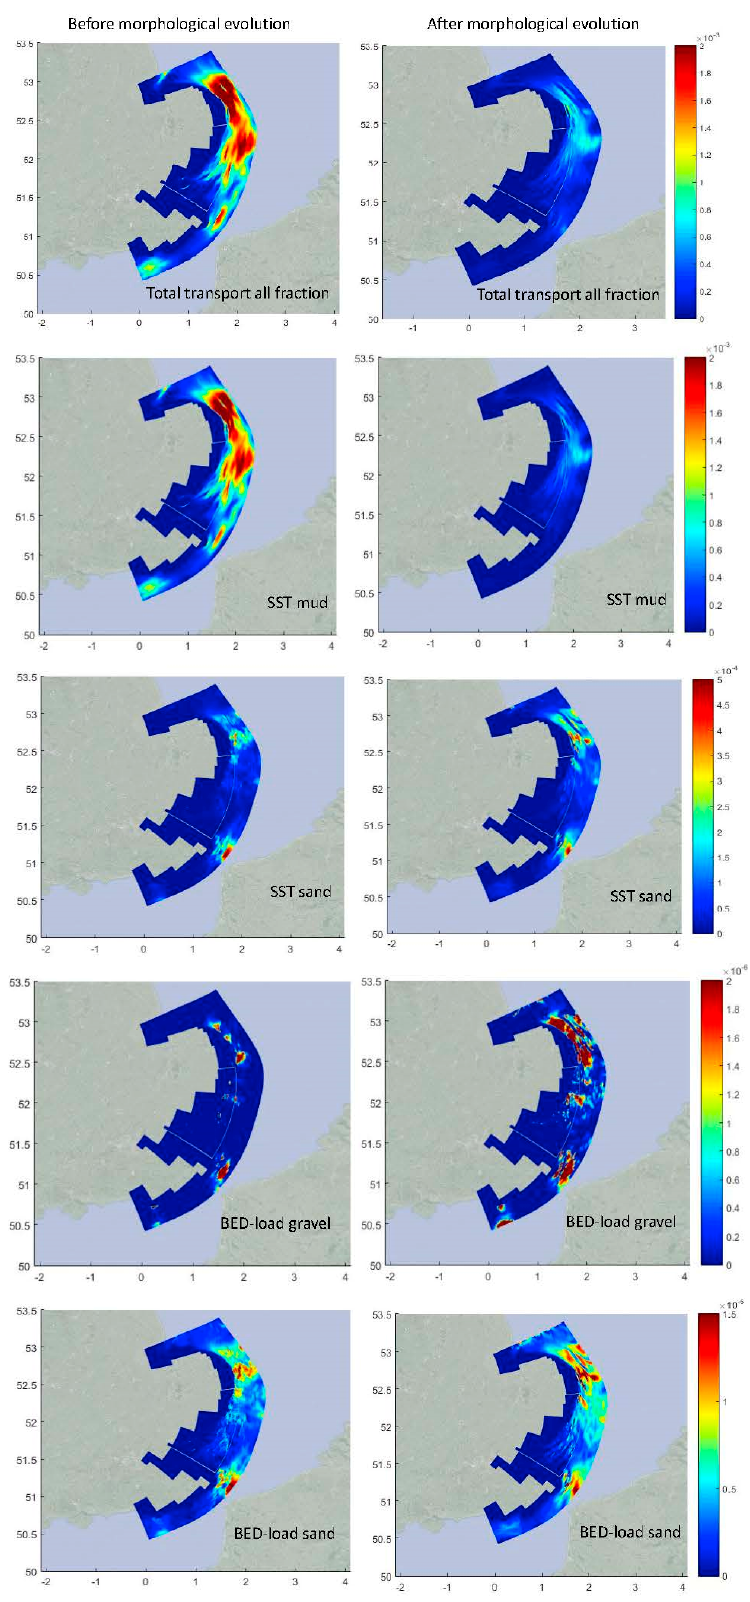
Figure A2. Net sediment transport for the different sediment fractions before and after the morphological evolution of the system. Results are presented for the highest spring tide of the study period (11 February 2009).